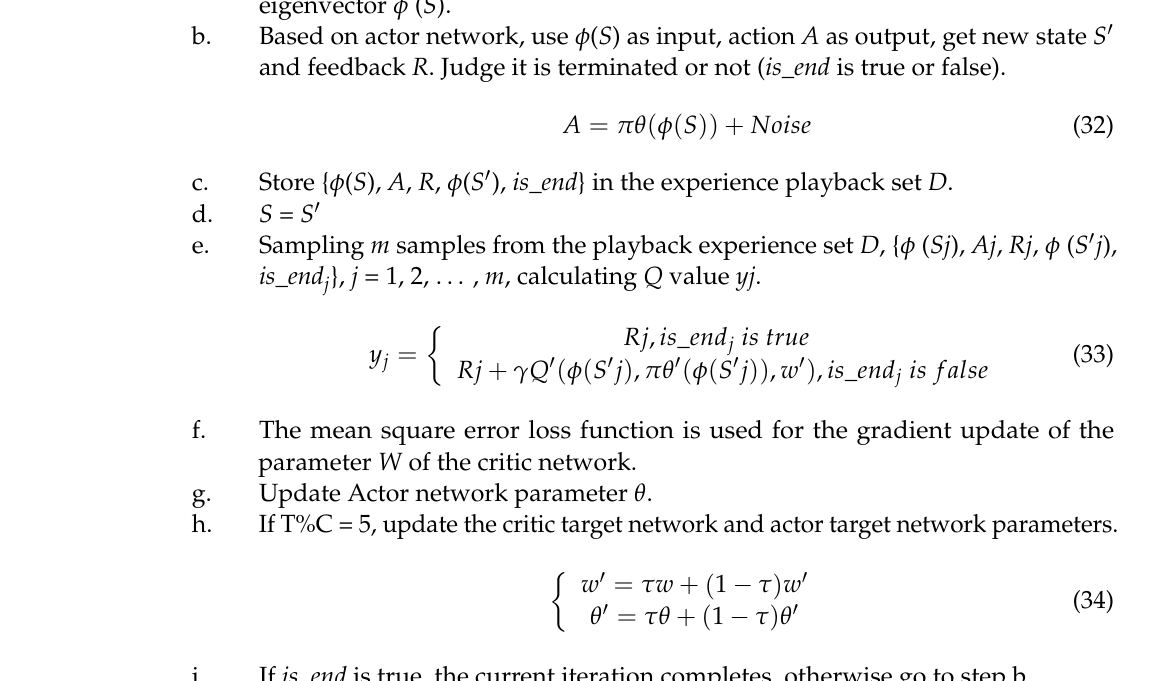
Table 3. Parameters of DDPG method in this paper.